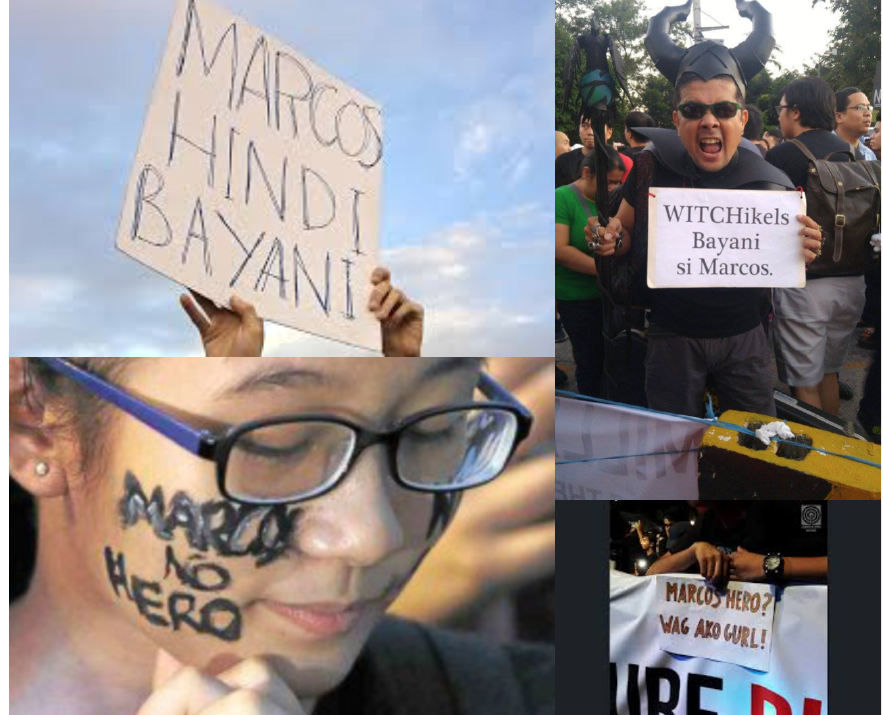
Figure 4. Monolingual and bilingual ‘Not a hero’ protest signs (clockwise, from bottom left): A girl prays during the protest, with “Marcos no hero” written on her face (Inquirer.net photo); A word-for-word version of “Marcos no hero” in Tagalog, above (From Kevin Mandrilla Facebook page); ‘Gayspeak’ protest sign asserts “No way is Marcos a hero” (left) (Facebook photo); and, a sign in slang above proclaims “Girl, don’t try to convince me that Marcos is a hero” (Facebook